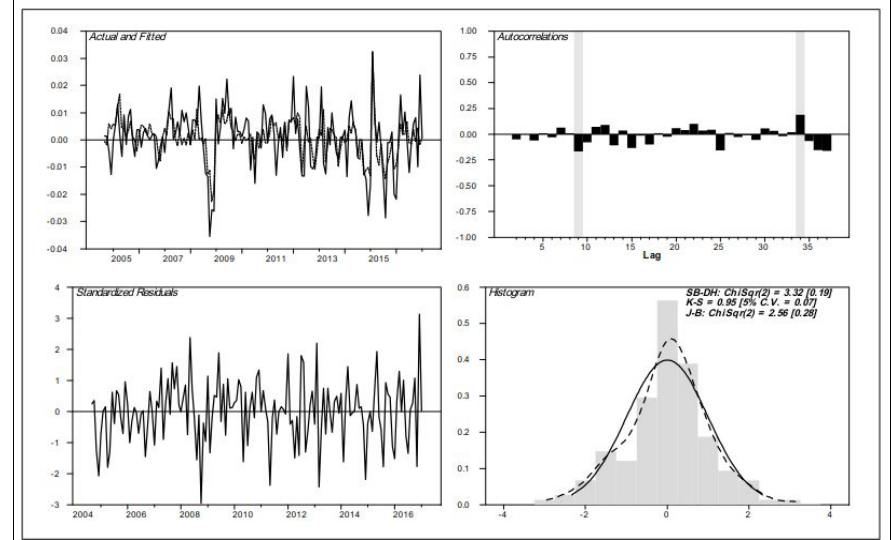
Figure 6: Graphs of actual and fitted change in the relative price between Greece and Germany (upper left hand side panel), the standardized residuals (lower left hand side panel), the residual autocorrelogram (upper right hand side panel), and the residual histogram compared to the normal